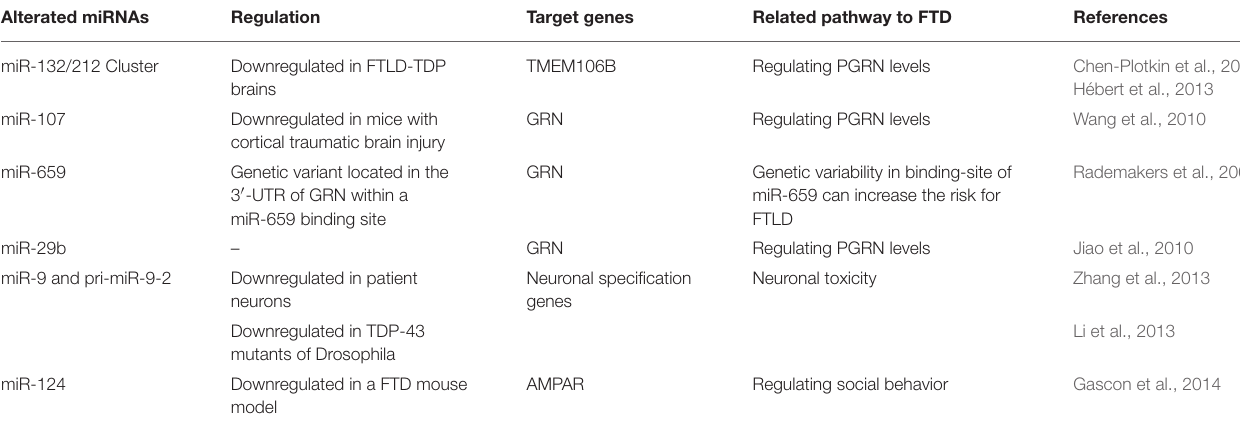
TABLE 1 | miRNAs involved in